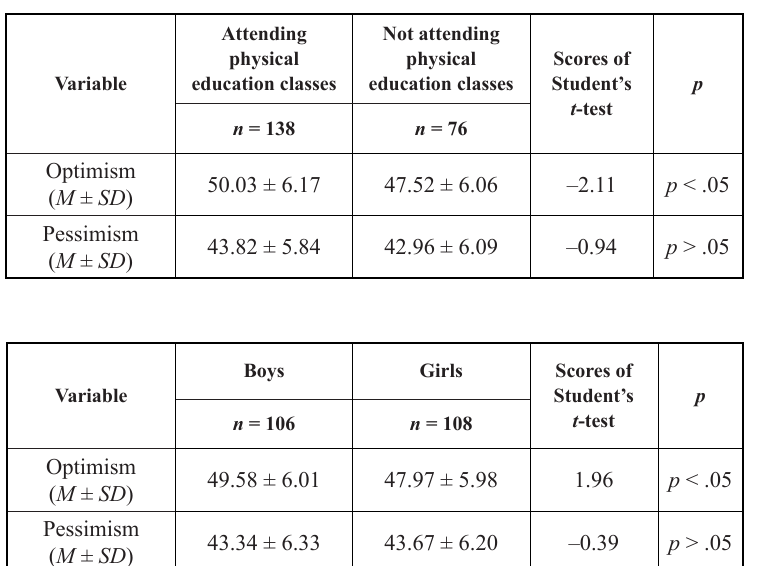
Note. ( M ± SD ) – mean and standard